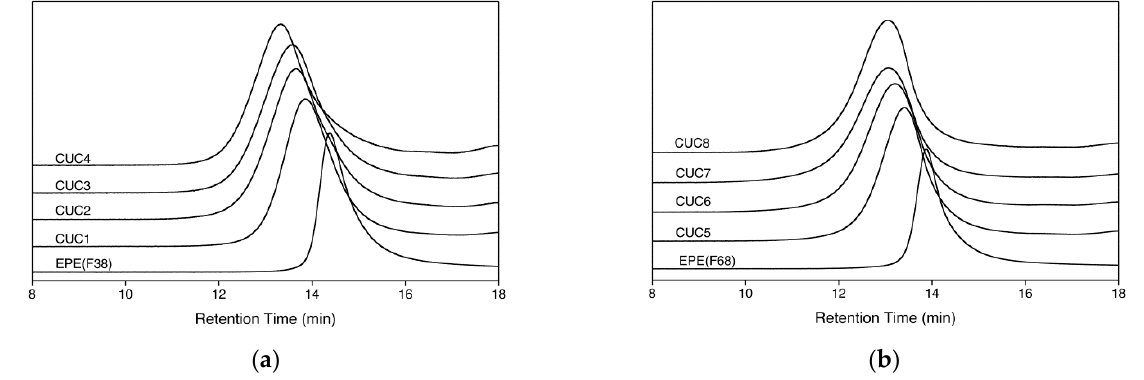
Figure 1. SEC chromatograms of CUC copolymers compared with respective macro-initiator EPE. ( a ) CUC1–CUC4 and ( b ) CUC5–CUC8 series. Table 1. Synthesis variables and molecular weight data of CUC copolymers.